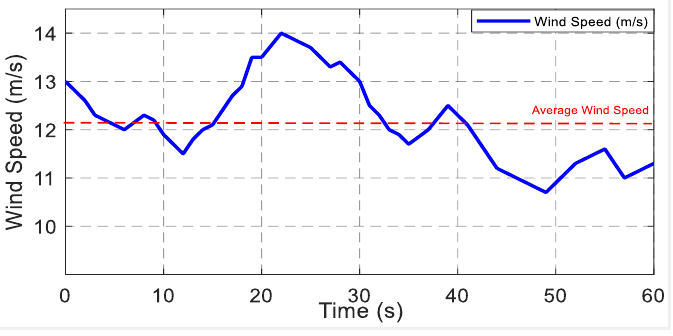
Figure 18. The real wind speed profile (12.15 m/s average speed).